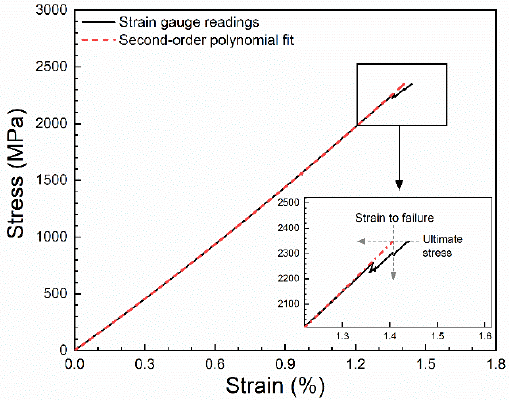
Figure 5. Example of experimental stress–strain curve and second-order polynomial fit showing the approach used to determine strain to failure.